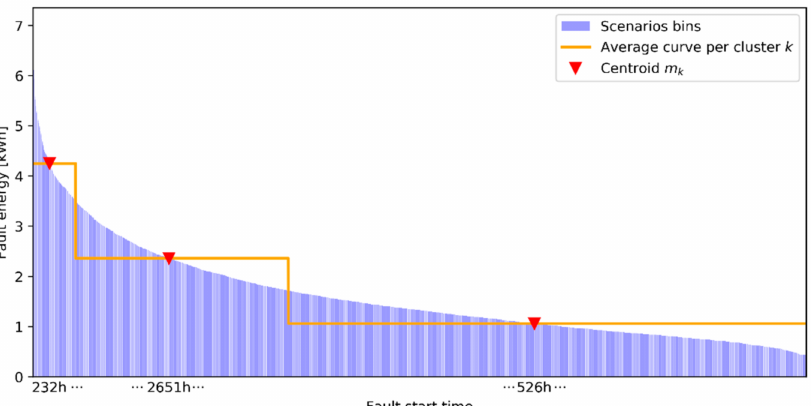
Figure 11. Annual 8 h power fault demand duration curve, for a residential household, with scenarios arranged in descending